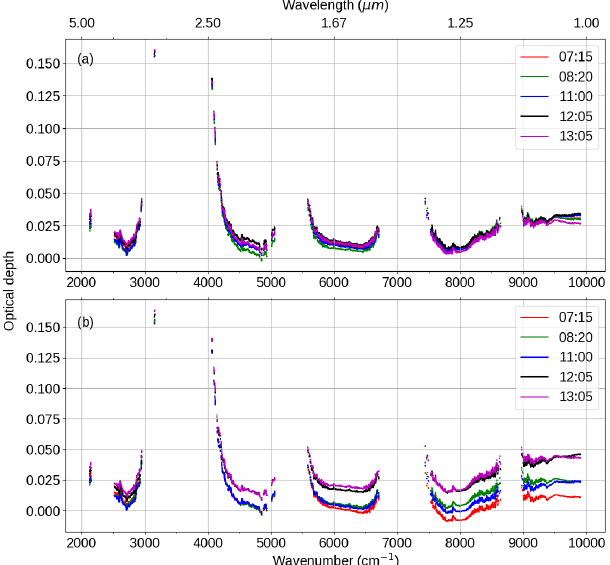
Figure 9. Observed time-varying continuum optical depth derived from the closure method at different times throughout 18 Septem- ber 2008, (a) with time-averaged aerosol as observed by the Mi- crotops and (b) with time-varying aerosol. The uncertainties are not shown for visual clarity, but are of the order ∼ 0 . 04 ( k =